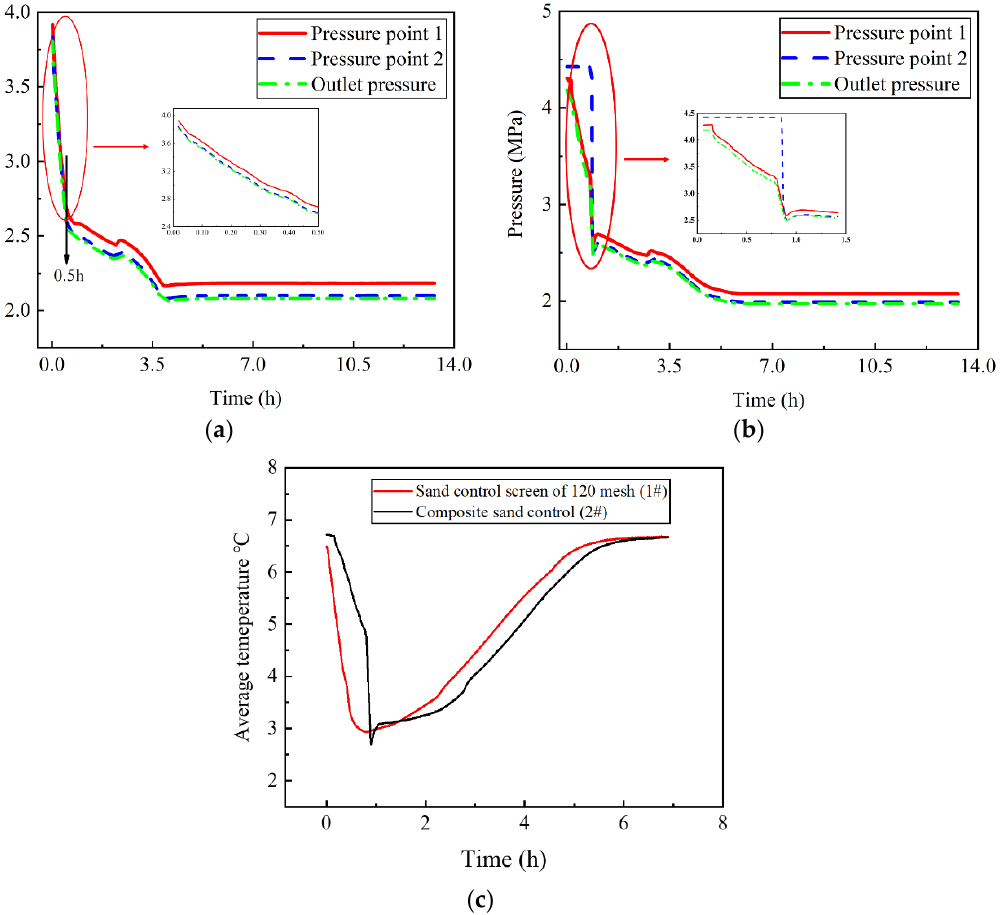
Figure 10. ( a ) Pressure change diagram of 120 mesh sand-control screen in vertical well depressurization; ( b ) Pressure change diagram of 120 mesh sand-control screen + gravel packing in vertical well depressurization; ( c ) The average temperature change diagram of two different sand control method in vertical well depressurization.